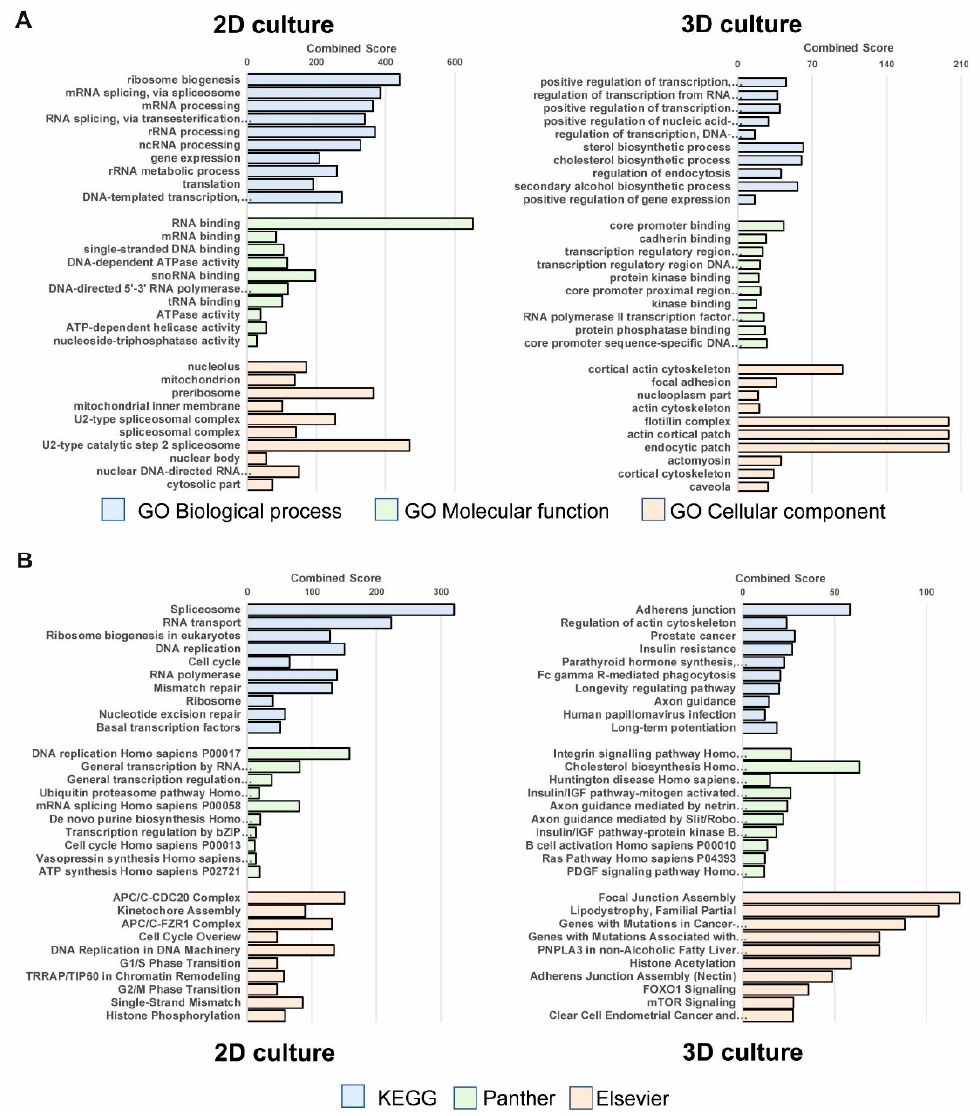
Figure 2. Analysis of differentially expressed genes in Mel Im in 2D culture and 3D alginate. ( A ) Top 10 results of the six enrichment analyses of GO domains and ( B ) pathway enrichment analysis. The results shown are sorted in ascending order by padj. The bars are representing the combined score.